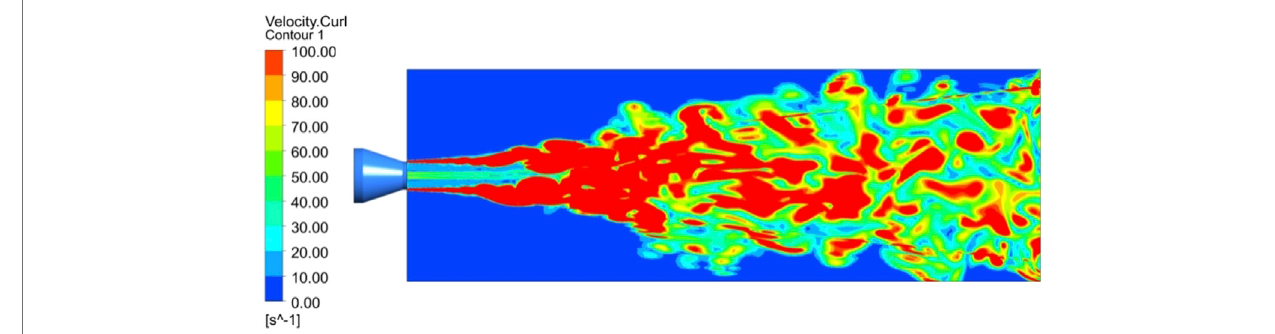
FIGURE 5 | Distribution of vorticity in the wake of water jet propulsion.